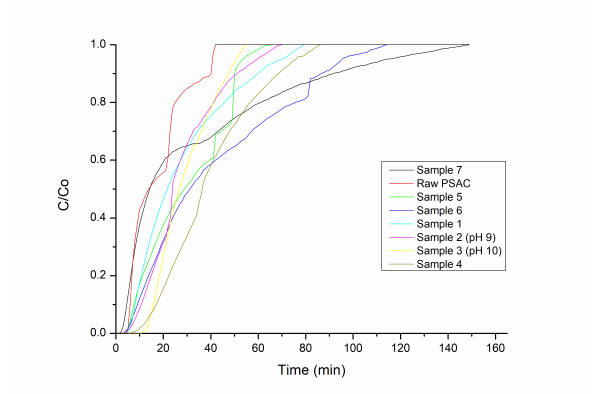
Fig. 7. H 2 S breakthrough curve of raw PSAC and Ni- PSAC adsorbents synthesized at different parameters.